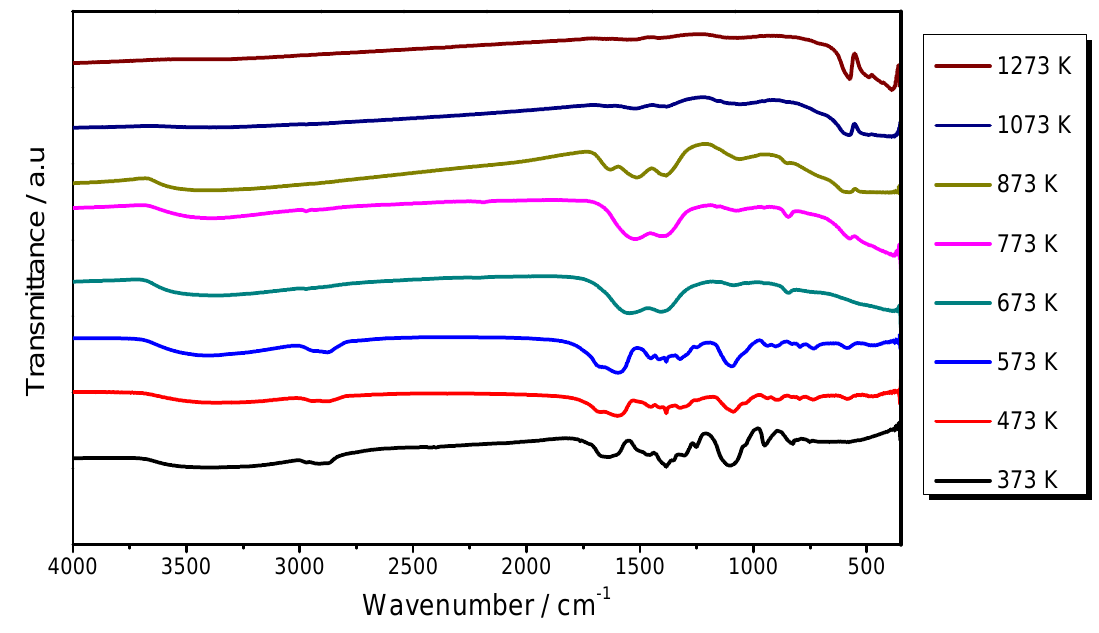
Figure 1. Fourier transform infrared (FTIR) spectra of Chemical evolution at Lu F127 modified system, F127/Lu =